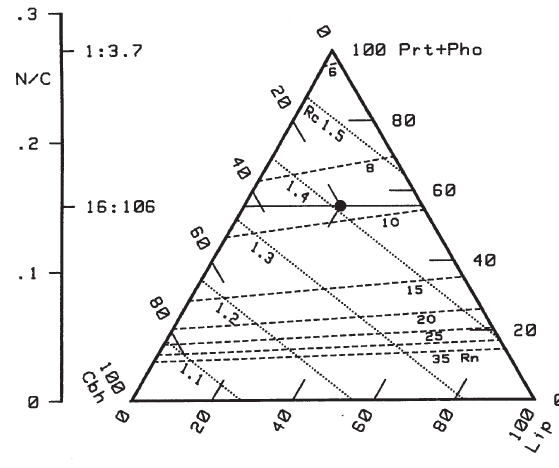
F IG . 1. -Ternary plots that represent the percentages of each group of biomolecules expressed in carbon (carbohydrates, lipids and proteins+chlorophyll+phosphorus compounds) that compose the phytoplankton. The point corresponds to the mean composition of plankton. The dotted lines indicate the location of samples with a mixing composition following the same R represent samples with mixing composition exhibiting the same . The continuous line points out a mixing composition that ful- R N fils C/N =